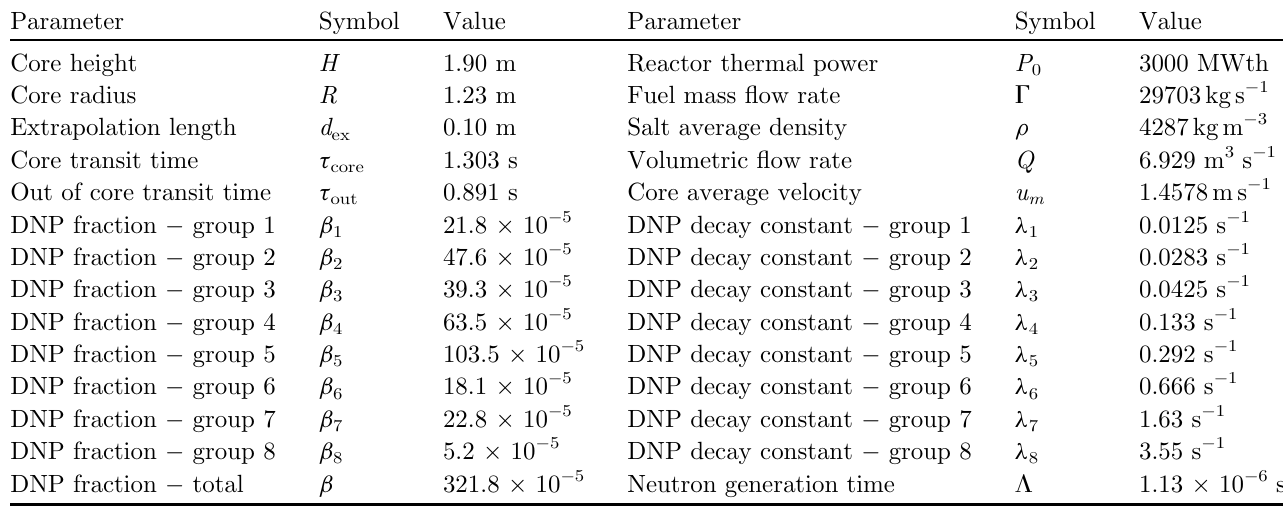
Table 7. Geometric and operational parameters used in the analytical 2-D MATLAB